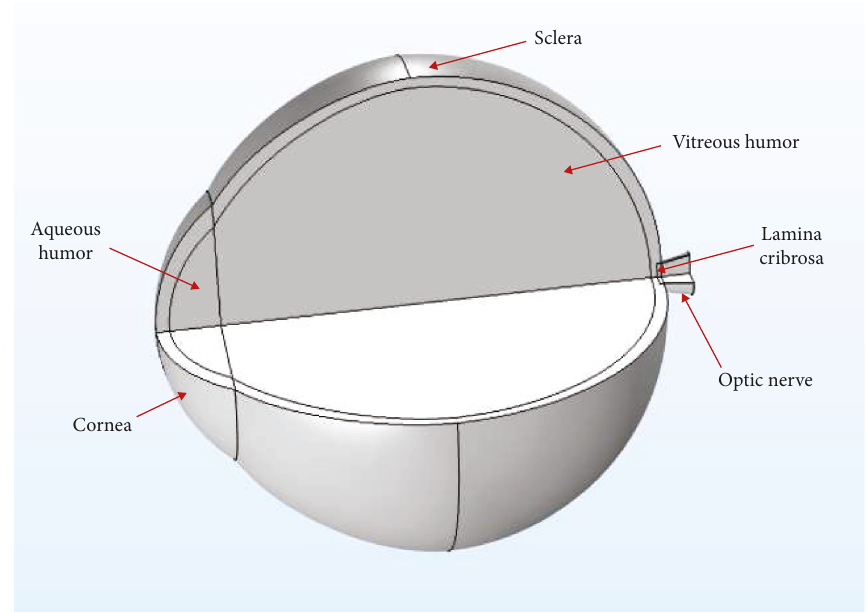
Figure 5: Three-dimensional model of the eyeball depicting the different ocular structures. The model was constructed using COMSOL Multiphysics v5.2 (https://www.comsol.com).